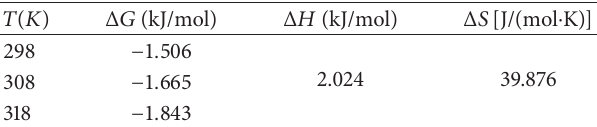
Table 4: Thermodynamic parameter for adsorption of Cr(VI) at different temperatures on NH 2